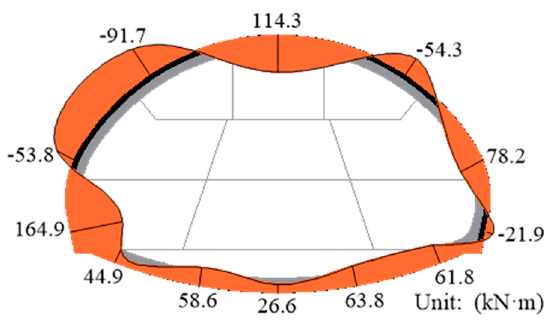
Figure 26. Final distribution of the axial forces of the secondary supports.